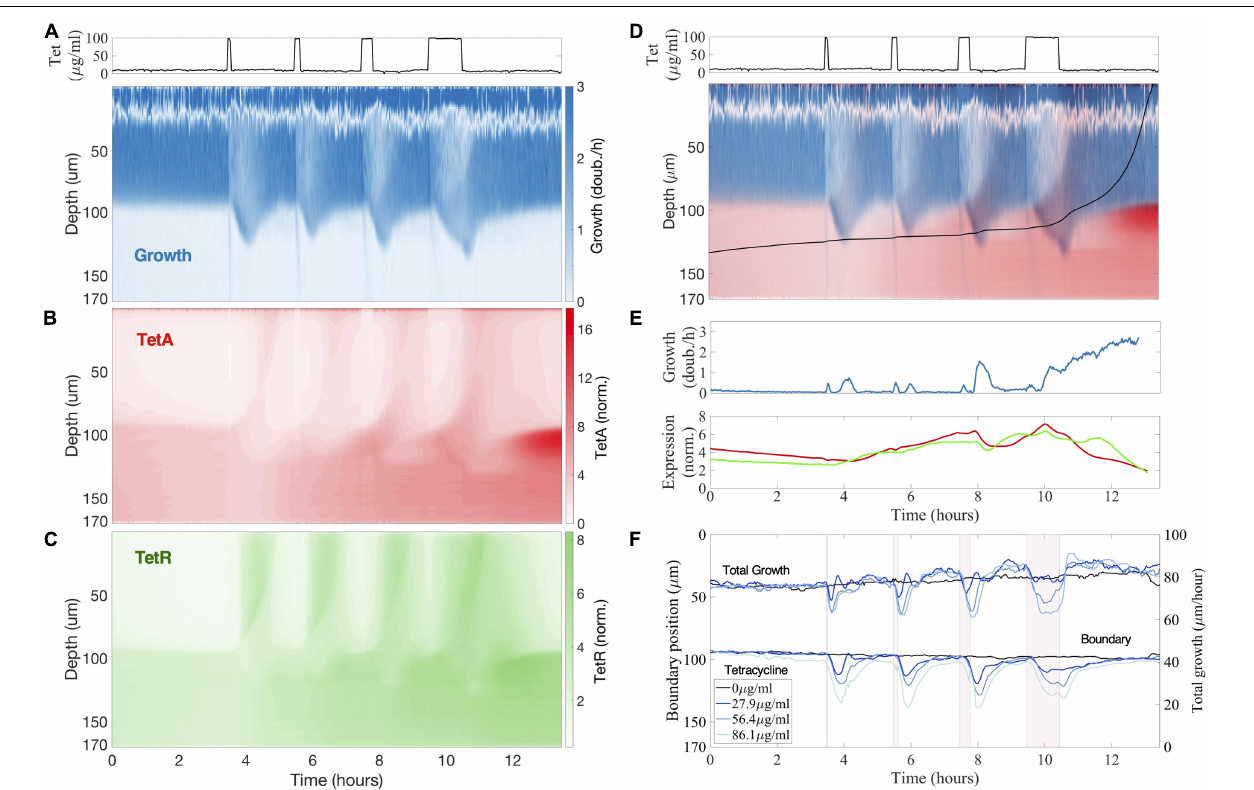
FIGURE 4 | Previous drug exposures build up resistance in the colony interior to resist future exposures. (A–C) Kymographs of (A) cell growth, (B) efflux pump TetA and (C) repressor TetR expression during a sequence of tetracycline exposures, with pulses of 5, 10, 20, and 60 min delivered every 2 h. Expression levels of TetA and TetR are normalized to basal expression levels in fast-growing cells in the absence of drug. Above, tetracycline concentration in the medium during the experiment. (D) Single cell trajectory : Superimposed kymograph of cell growth (blue) and TetA expression (red), with a black line showing an approximate trajectory followed by a single cell originating in the interior of the colony, calculated from the velocities. (E) Cell growth and expression of resistance genes along this trajectory. Cell growth is noisy near the top of the colony due to the difficulty in calculating velocities. (F) Position of the boundary between growing and arrested cells during drug exposure, defined as the depth of half-maximal growth at each timepoint. Total growth of the colony during the sequence of exposures, defined as the integral of the growth across the whole depth of the trap. Periods of exposure to tetracycline are depicted in pink shading. The different lines denote exposure to different drug